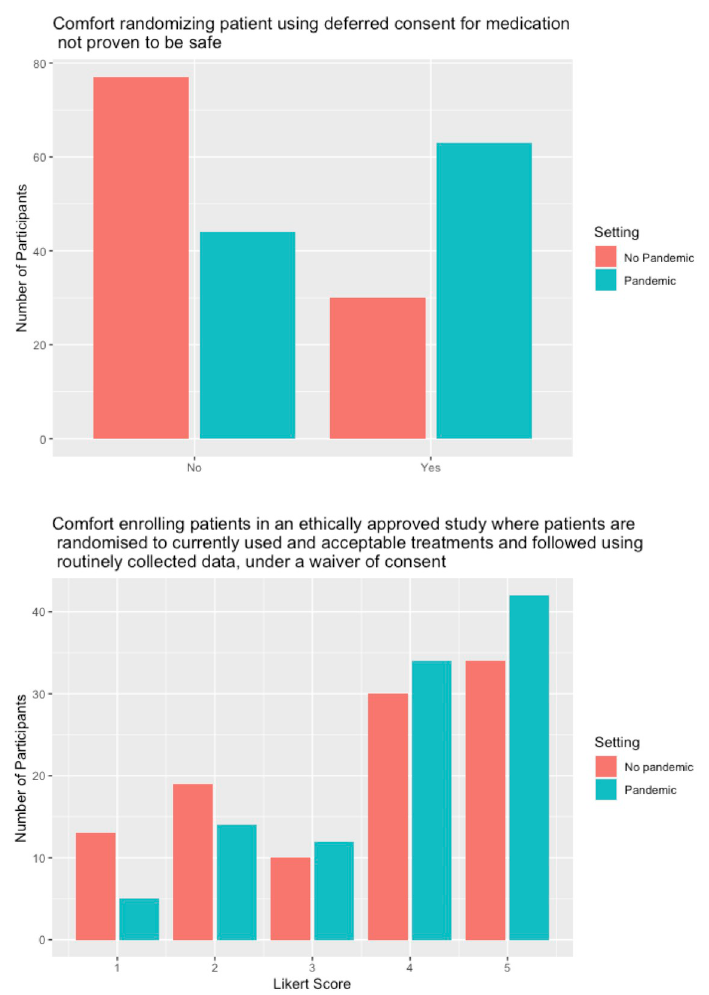
Fig 1. Comparison of comfort with research practices in pandemic and non-pandemic settings. (A) Comfort randomizing patients using deferred consent for an unproven medication, in which participants were more comfortable in pandemic settings than non-pandemic settings. (B) Comfort randomizing patients to a current therapy with routine data collection follow up, under a waiver of consent, which did not differ amongst participants between pandemic and non-pandemic